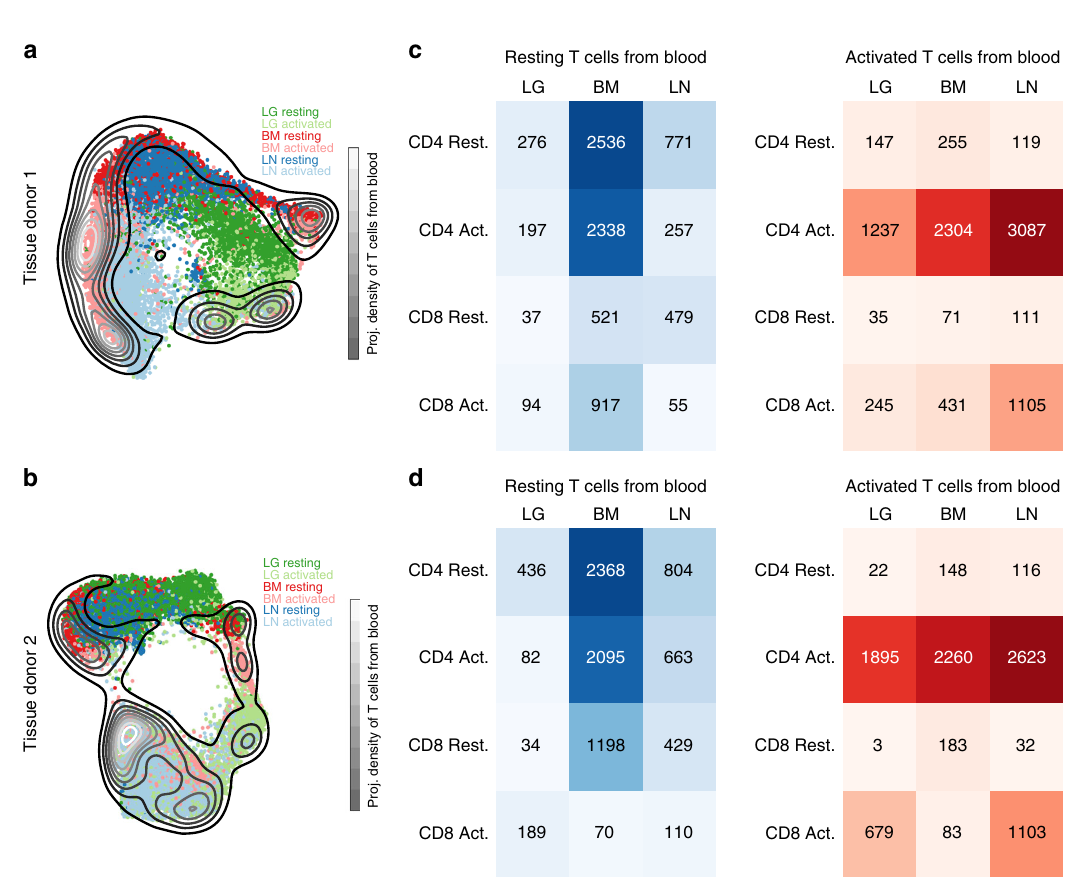
Fig. 2 Comparison of blood and tissue T cells. a UMAP embedding of T cells from tissue donor 1 colored by tissue and overlaid with a contour plot corresponding to the UMAP projection of the combined resting and activated T cells from two blood donors onto the tissue embedding. b Same as ( a ) for organ donor 2. c Heatmaps showing the number of blood T cells that project most closely to each tissue/stimulation status combination in the tissue donor 1 UMAP embedding. d Same as ( c ) for tissue donor